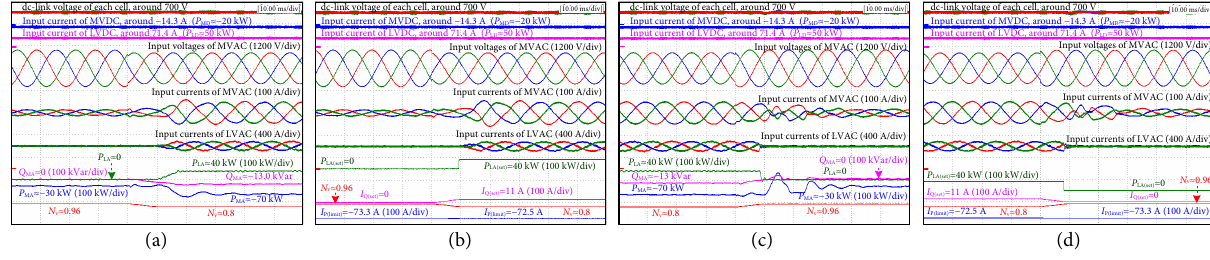
Fig. 19 Experimental results of LVRT Mode-2 in Case-2 of active-power configuration. (a) Real-time power curve in the voltage sag process. (b) Power command curve in the voltage sag process. (c) Real-time power curve in the voltage recovery process. (d) Power command curve in the voltage recovery